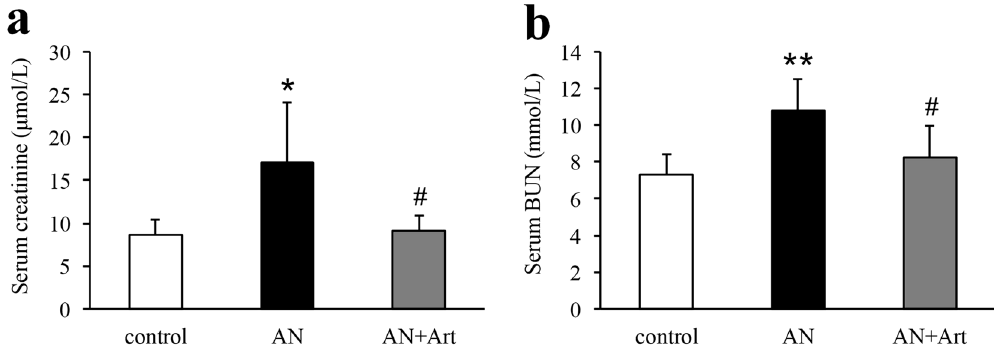
Figure 9. The levels of ( a ) serum creatinine and ( b ) BUN in each group. n = 6 per group. * P < 0.05 and ** P < 0.01 versus control; # P < 0.05 versus